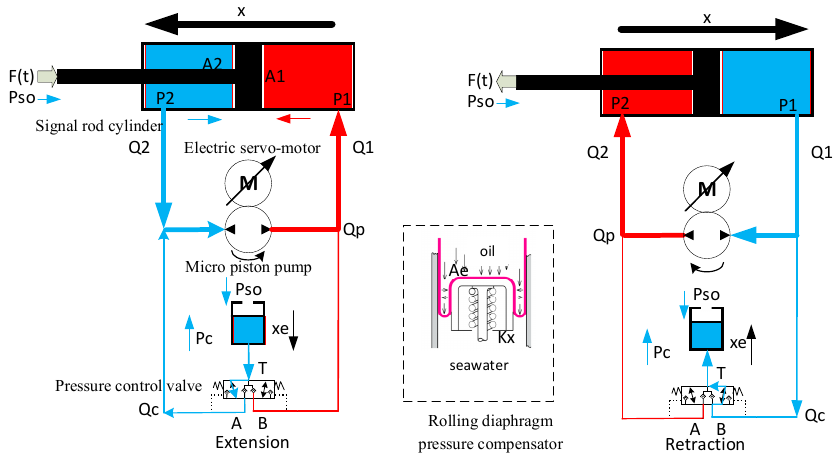
Figure 2. Hydraulic schematic diagram for EHA extension and retraction with pressure compensa- tor.